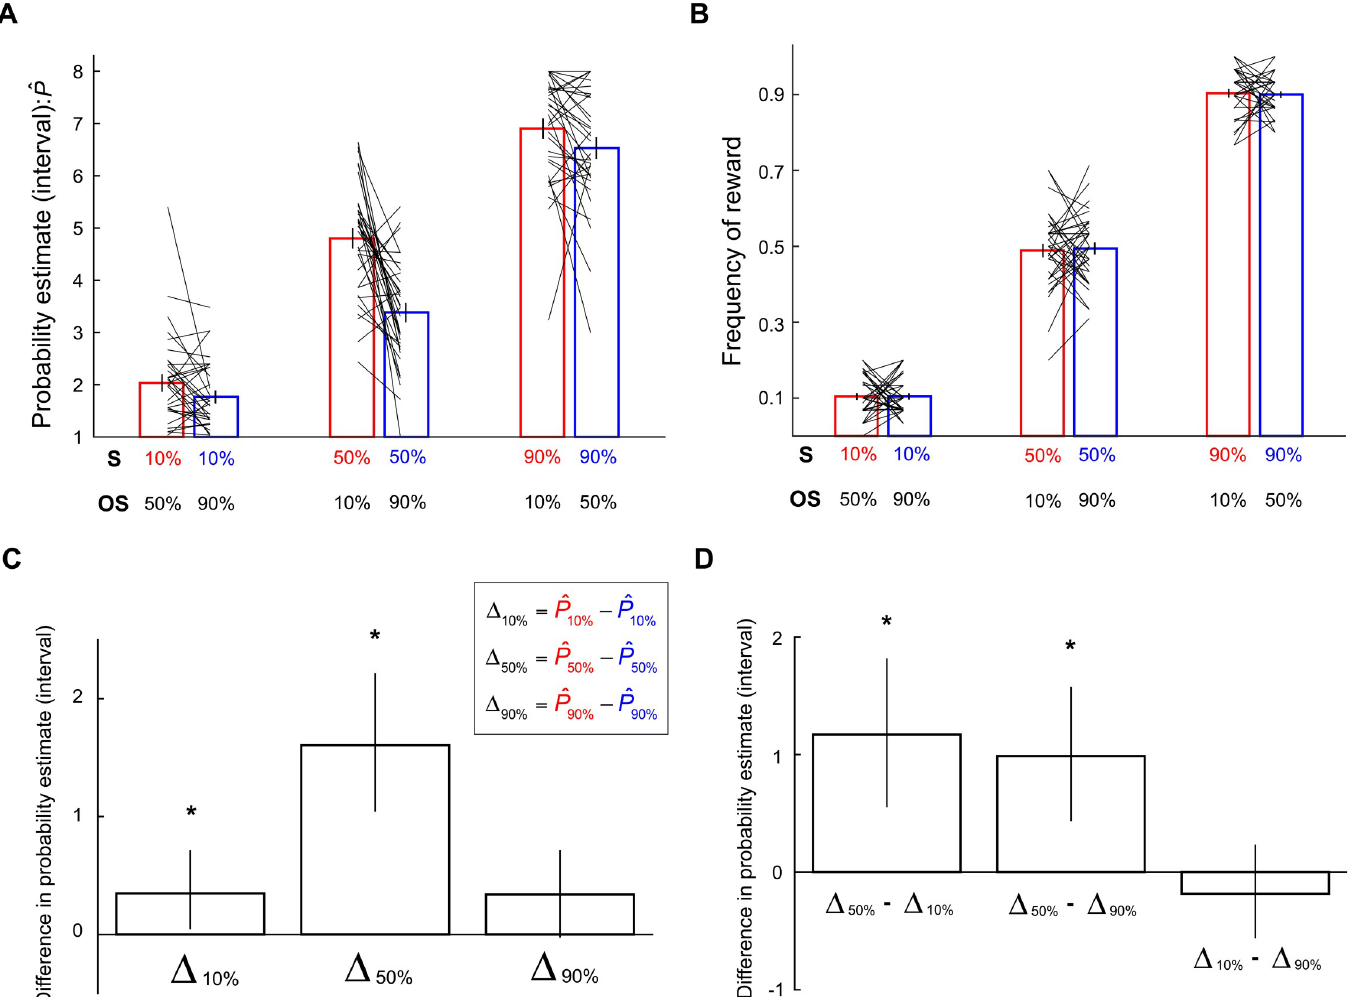
Fig 2. The effects of context on probability estimates. Experiment 1: (A) Subjects’ estimates of probability of reward associated with different stimuli. Stimuli carrying the same reward probability are plotted together. The vertical axis represents interval estimates: 1:[0%–5%], 2:[5%–20%], 3:[20%–35%], 4:[35%–50%], 5:[50%–65%], 6: [65%–80%], 7:[80%–95%], 8:[95%–100%]. The bars represent the mean probability estimates (across subjects), and the tilted black lines represent individual subjects’ data. Error bars represent ± 1 SEM. (B) Frequency of reward the subjects experienced during the experiment. Conventions are the same as in Fig 2A. (C) Context-induced difference in probability estimates. For each reward probability—10%, 50%, 90%—the mean difference (across subjects) in probability estimates— Δ 10% , Δ 50% , Δ 90% — between contexts is plotted. In the equations that define Δ 10% , Δ 50% , and Δ 90% shown in the graph, conventions of the color codes for probability estimates ( ^ P ) are the same as in Fig 2A. For example, Δ 50% is computed by subtracting ^ P (in blue), which represents probability estimate of the 50% reward stimulus in the [50%, 90%] context, 50% from ^ P (in red), which represents probability estimate of the 50% reward stimulus in the [10%, 50%] context. We obtained Δ from each subject based on his or her 50% mean probability estimates (across trials) and computed the mean of Δ across subjects. Error bars represent 95% bootstrap confidence interval of the mean Δ (across subjects). (D) Comparing the size of context effect between different reward probabilities. Bars indicate the mean difference in context effect (across subjects) for stimuli associated with different probabilities. For example, Δ 50% − Δ 10% compares context effect between 50% reward and 10% reward. Error bars represent 95% bootstrap confidence interval of the mean differences in context effect (across subjects). Data underlying these graphs can be found in https://osf.io/48j7m. OS, the other stimulus present in the same context as the stimulus of interest; S, stimulus of interest. https://doi.org/10.1371/journal.pbio.3000634.g002 the actual reward frequency of S ( f ) and the other stimulus ( f ) she or he experienced in the S OS same context. For each reward probability, we regressed the mean probability estimates of each subject (across trials) against f and f . For example, for 50% reward, each subject con- S OS tributed two data points—his or her mean probability estimate of the 50% stimulus in the [10%, 50%] context ð � P Þ and [50%, 90%] context ð � P Þ . The values of the f S 50% j½ 10% ; 50% � 50% j½ 50% ; 90% �